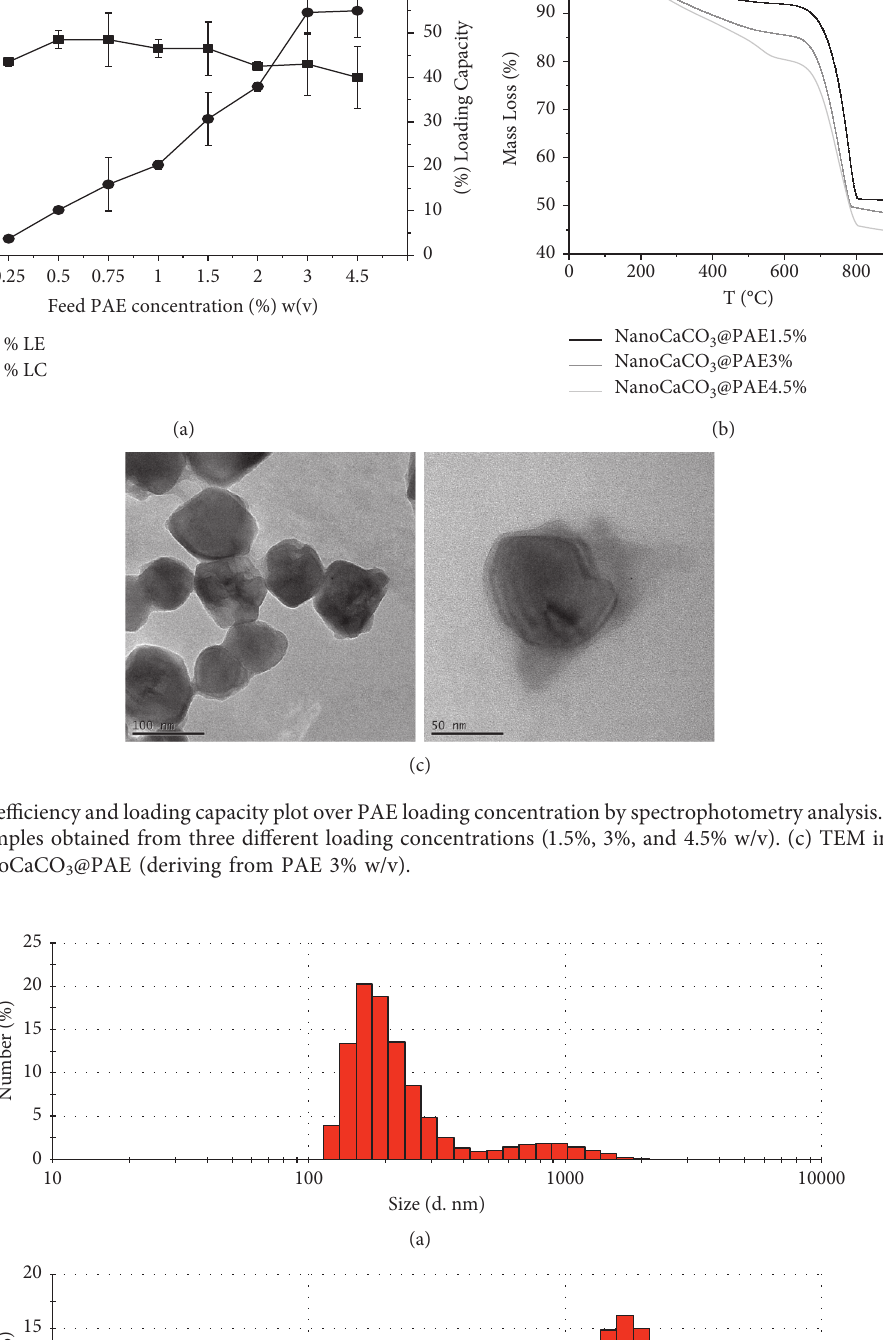
3 @PAE (a) and nanoCaCO 3 @PAE@CH (b) nanoformulations in